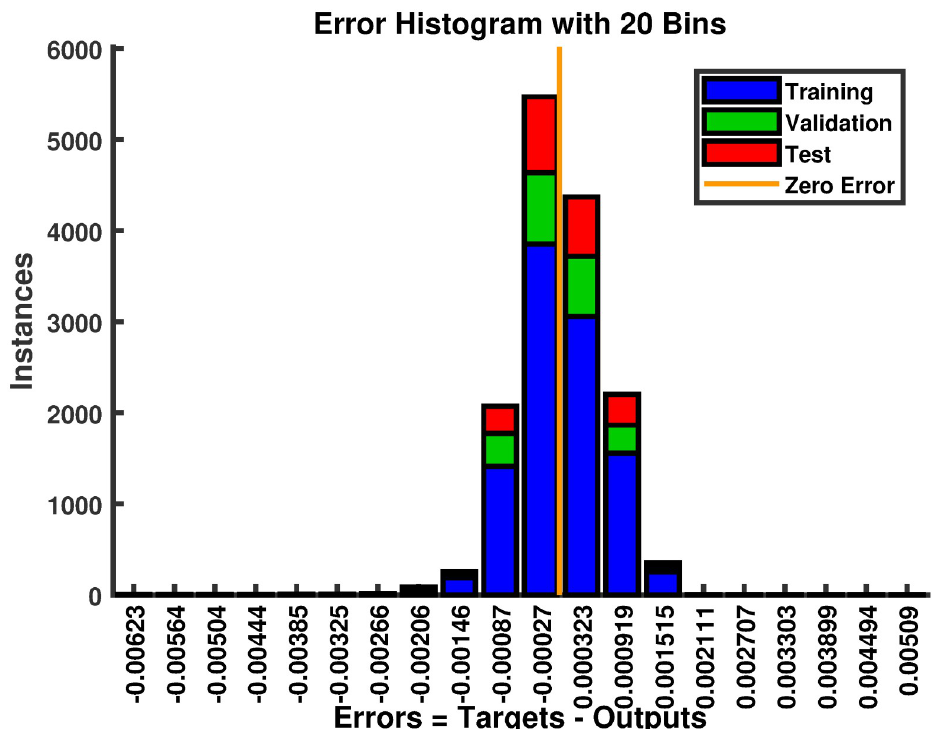
Fig 11. The error histogram during the estimation of V ref